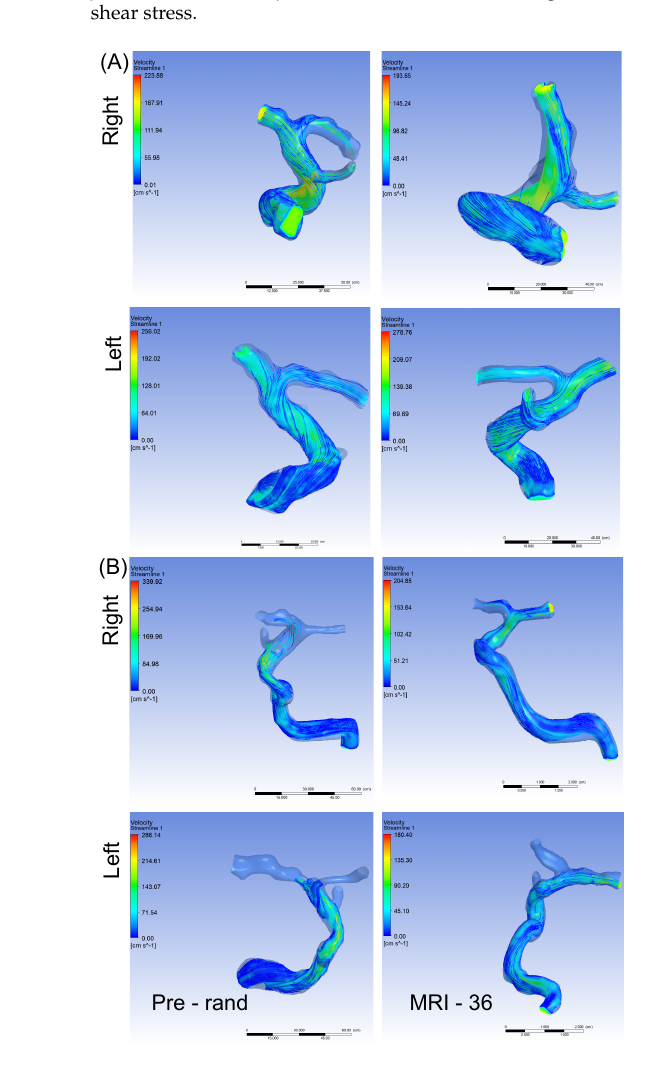
Figure1. Ourmulti-typenoveltyexperimentalenvironmentusesCartPole3D,wherethegoalisto Figure 2. Panel “( A )” represents velocity in a participant in the observation arm with MRA at pre- keepthepolebalanced. Theenvironmenthasacontrollablecart(green)balancingapole(blue). It alsohasaddedindependentlymovingenvironmentalagents(red). Theenvironmentcanbechanged randomization and after 36 months. In the right ICA, TAMV decreased from 168 cm/s to 125 cm/s after 36 months, while the left ICA TAMV increased from 114 cm/s pre-randomization to 166 cm/s at 36 months. Panel “( B )” represents velocity in a participant in the cRBC treatment arm with MRA at pre-randomization and after 36 months. In the right ICA, TAMV decreased from 186 cm/s to 154 cm/s after 36 months, while the left ICA TAMV unchanged at 102 cm/s pre-randomization and 105 cm/s at 36 months. cRBC = chronic red blood cell infusion, MRA = magnetic resonance angiography, TAMV = time averaged mean